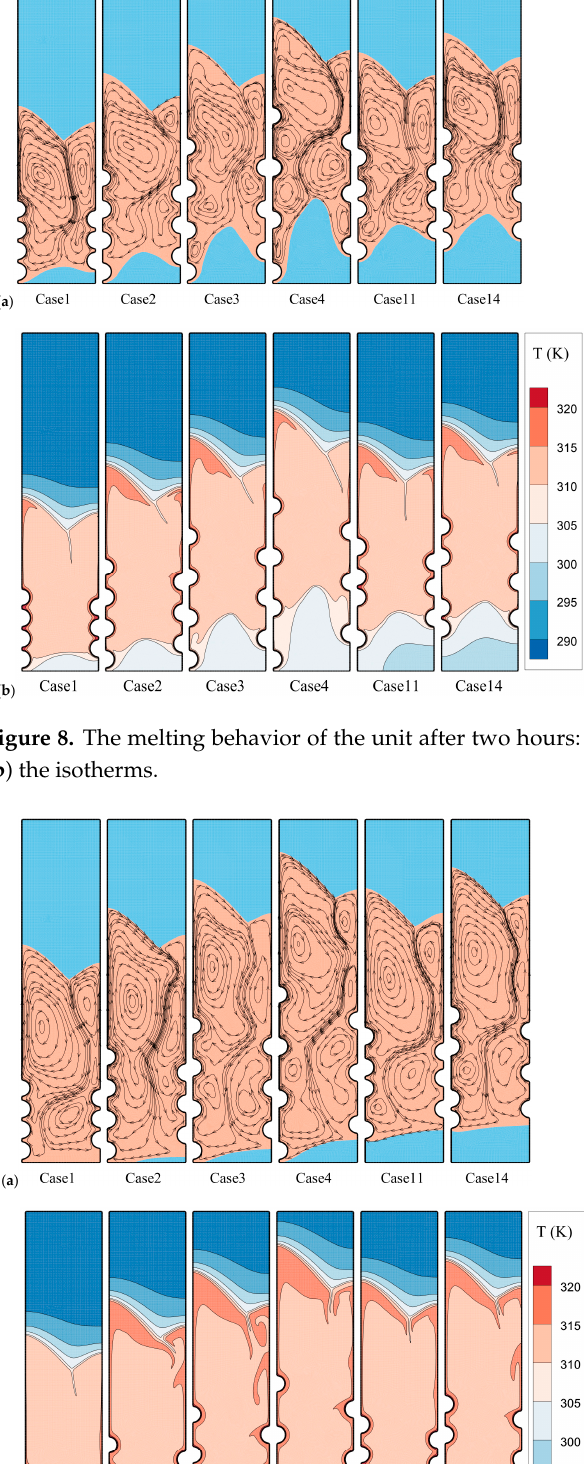
Figure 9. The melting behavior of the unit after three hours: ( a ) The streamlines and melting field; ( b ) the isotherms. Figure 10 shows almost similar results to Figure 9, but in this case, tubes competed to push the melting interface toward the top regions. After one hour (compared to Figure 9), the cases with the first tube not at the lowest location (cases 11 and 14) could not show any significant progress in charging of the PCM at the base of the unit. After four hours, all of the tubes were surrounded by liquid, and there was sufficient space for the flow circulation in the liquid region. The streamlines could mainly dictate the difference be-